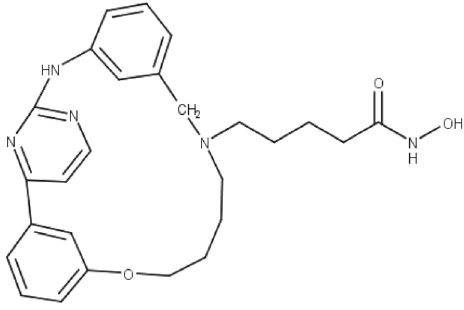
FIGURE 28 - Structure of compound 32, the most active inhibitor against HDAC, FLT3, and JAK2.